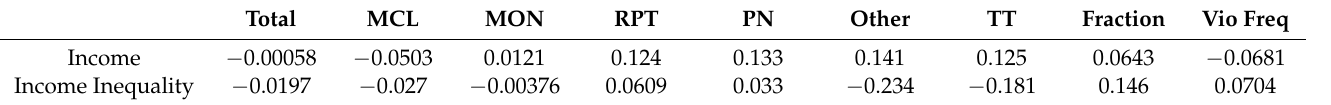
Table 2. Spearman’s rank correlation coefficients matrix.